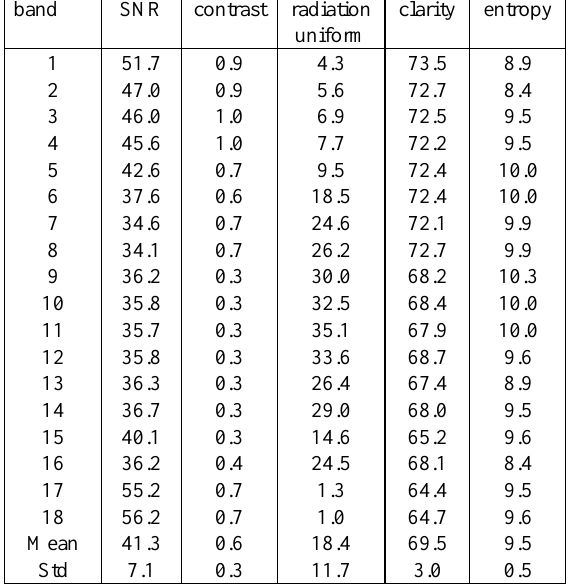
Table 4. Quality evaluation results of MWI data in Qinghai Lake